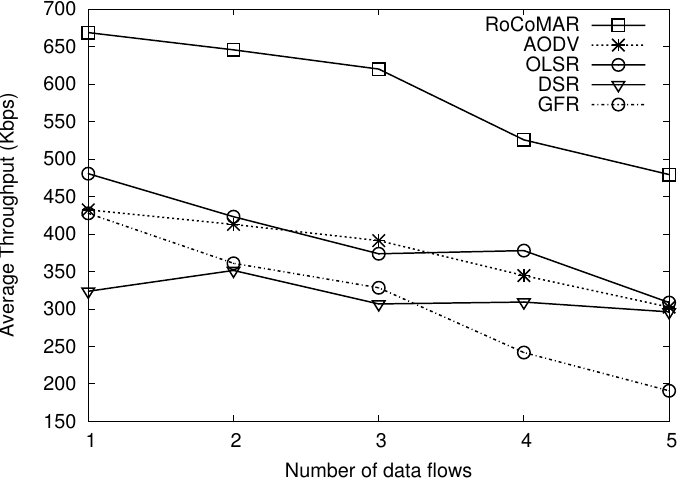
Figure 11. Effects of the number of data flows on average throughput.